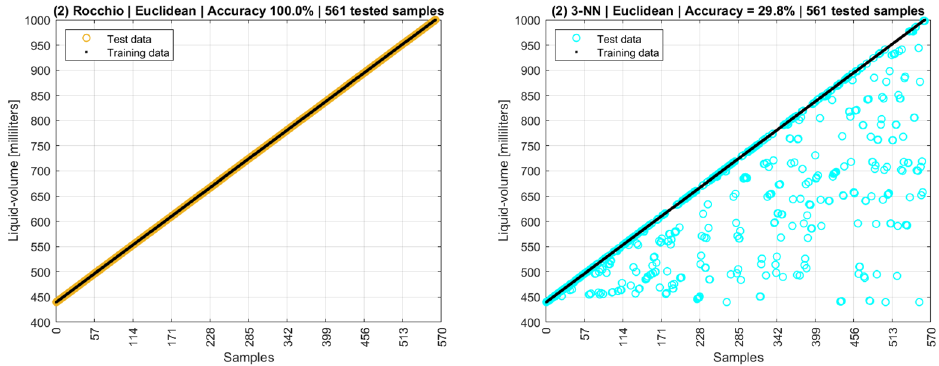
Figure 19. Rocchio and k-NN accuracies with centroids of mean values.